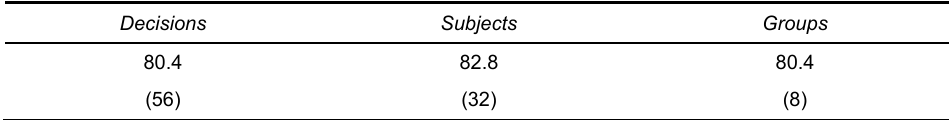
Table 3: Average percentage of votes cast by subjects in position A or B to award the prize to the outgoing subject (position C) in the prize game (N) Decisions Subjects